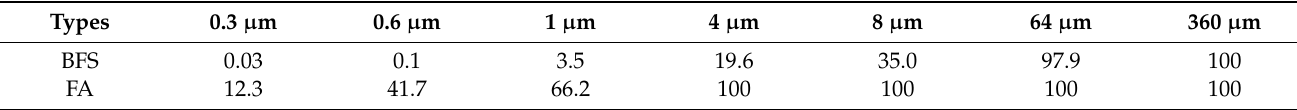
Table 1. Particle passing percentage of raw materials (%).